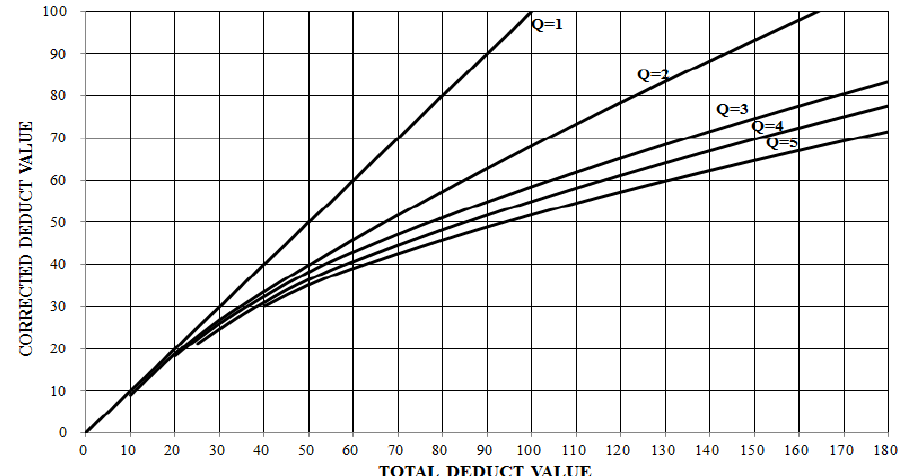
Figure 10. Developed corrected deduct value curves for concrete pavement.